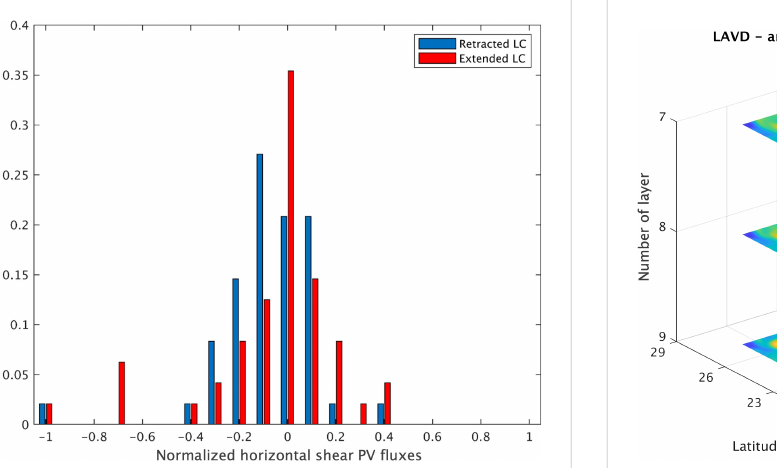
FIGURE 7 Coherent anticyclonic boundary (black) superimposed on the normalized LAVD fi eld in model layers 7, 8, and 9 on June 26,